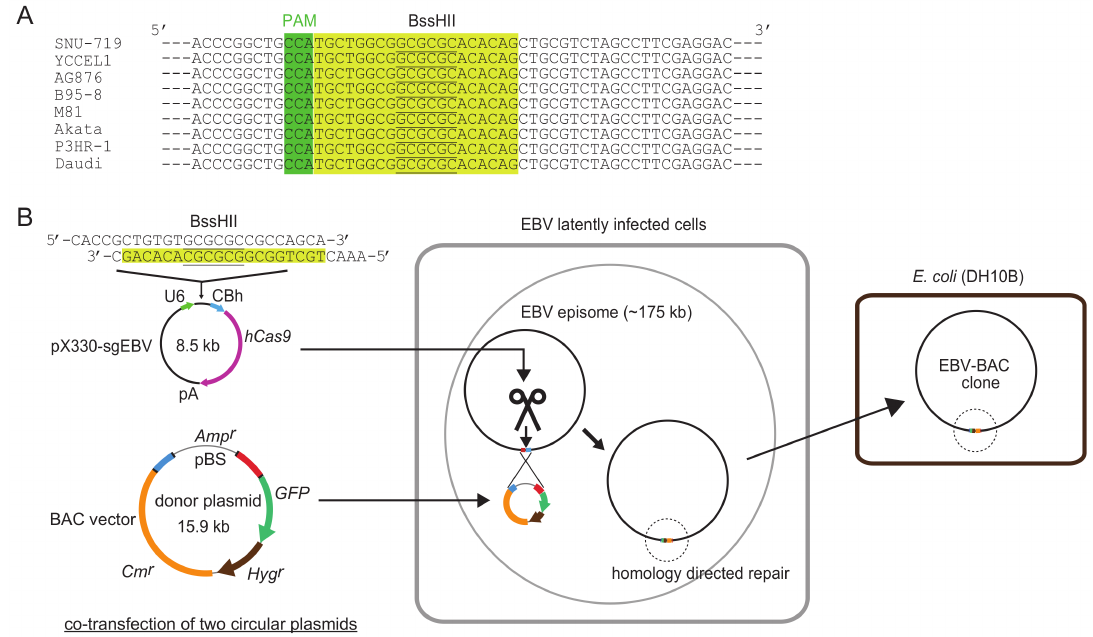
Figure 1. Schematic illustration of clustered regularly interspaced short palindromic repeats (CRISPR)/Cas9-mediated Epstein-Barr virus (EBV)-bacterial artificial chromosome (BAC) cloning. ( A ) CRISPR/Cas9 target sequence used for EBV-BAC cloning. Twenty bp sequences are shaded in yellow, and PAM sequences (5 (cid:48) -NGG) are shaded in green. BssHII sites are underlined. Note that the target sequence is 100% conserved among representative EBV strains so far sequenced. ( B ) Outline of EBV-BAC